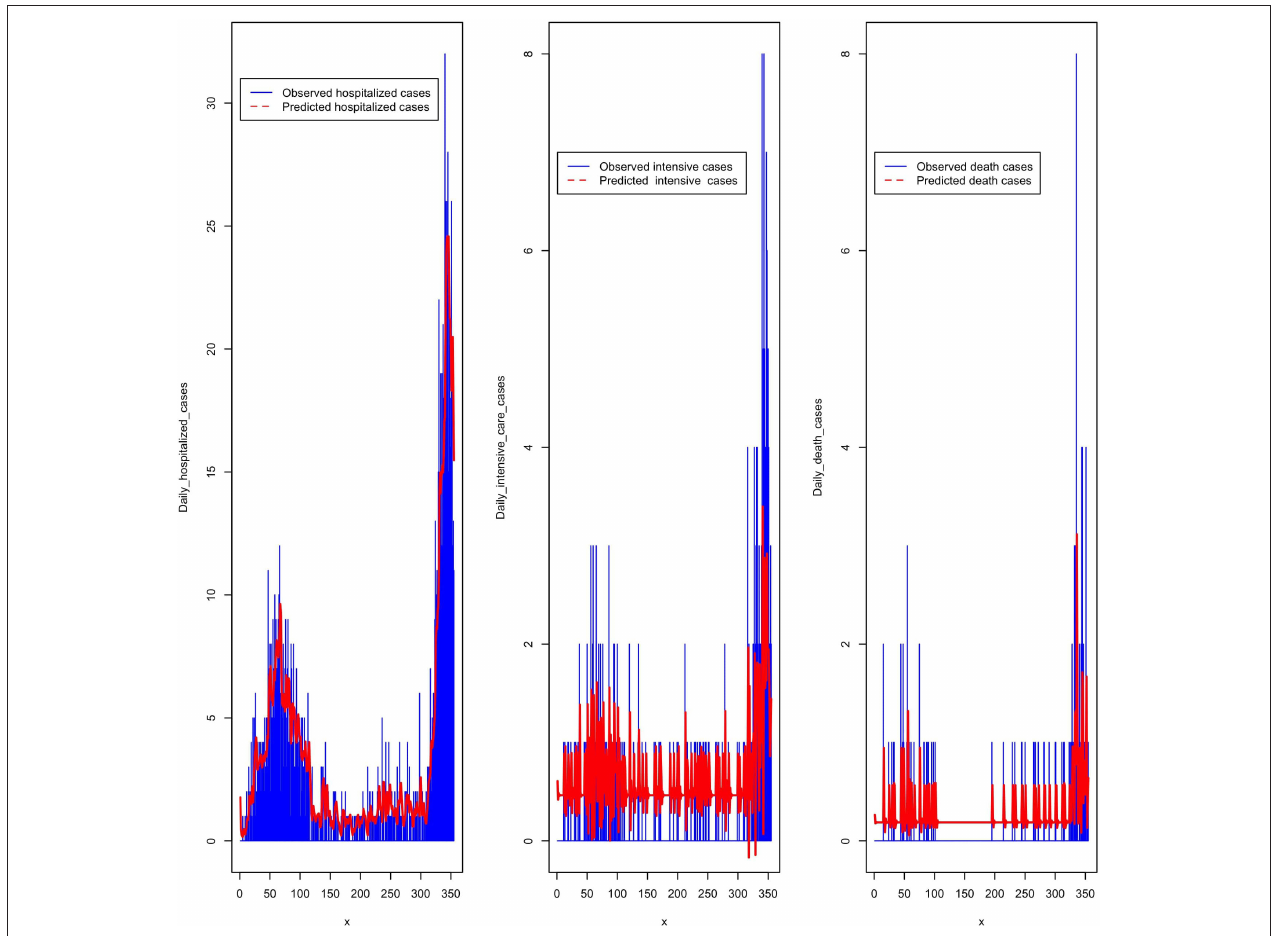
FIGURE 9 | Predicted daily hospitalized, intensive care, and death cases from March 2020 to February